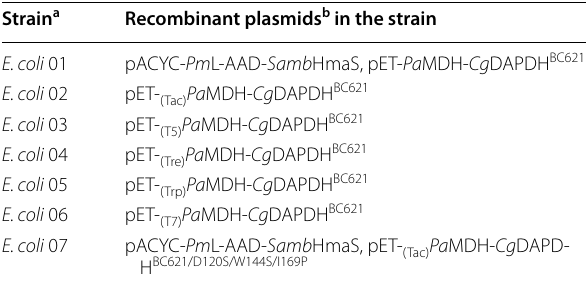
L-AAD: l -amino acid deaminase; HmaS: 4-hydroxymandelate synthase; MDH: ( S )- mandelate dehydrogenase; DAPDH: meso -diaminopimelate dehydrogenase a The strains were constructed by transforming the corresponding recombinant plasmids into E. coli BL21 (DE3) express strains (New England Biolabs) b The recombinant plasmids were constructed on pACYCDuet-1 or pETDuet-1 (Novagen)